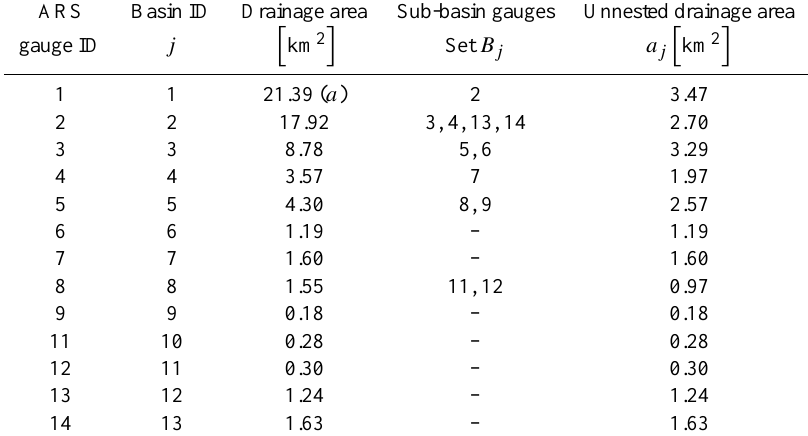
Table 1. Properties of gauges used in this study.